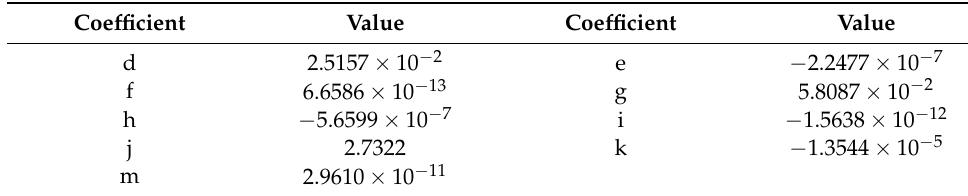
Table 3. Coefficients for the C d quadratic Re number